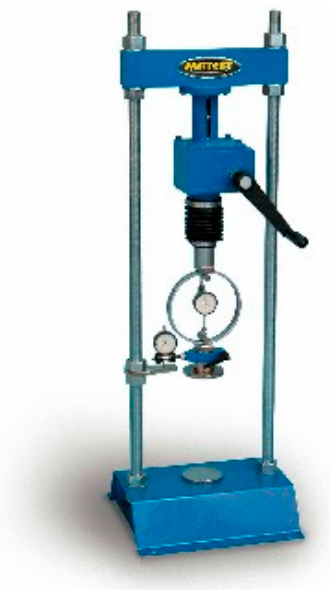
Figure 3. Unconfined compression test equipment.